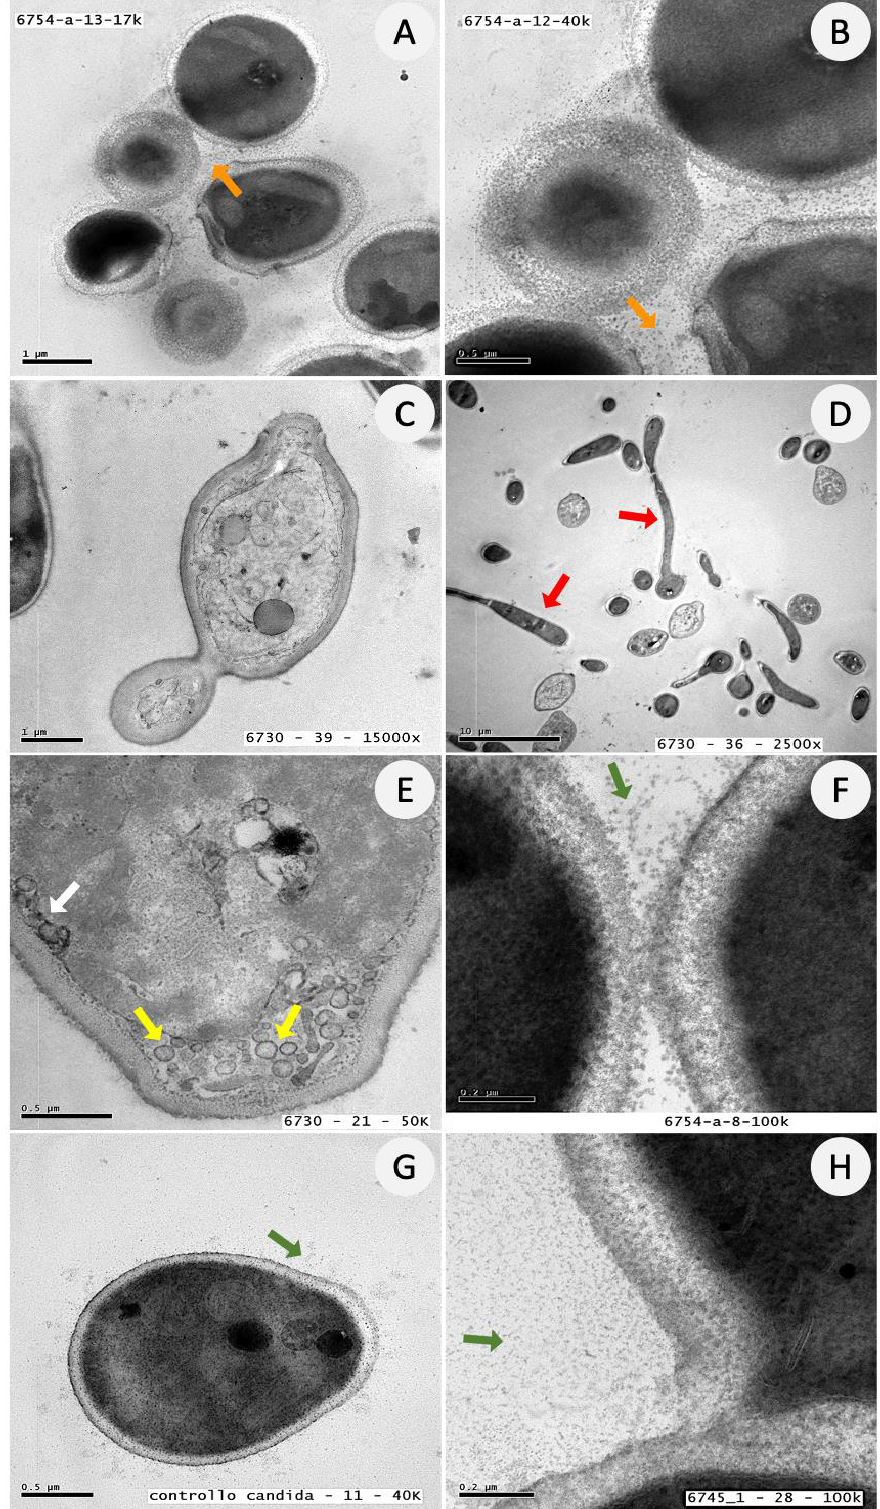
Figure 5. Ultrastructural features of C. albicans cells by TEM analysis. A-H: Representative images of C. albicans control cells. ( A,B ) cells arranged in small clusters and surrounded by extracellular granular material (orange arrows); ( C ) Candida replication in budding yeast; ( D ) budding yeasts and true hyphae (red arrows); ( E ) cells showing numerous intracytoplasmic vacuoles (yellow arrows) and EV (white arrow) at the periplasmic space; ( F,G,H ) cells secreting extracellular granular material (green arrows).